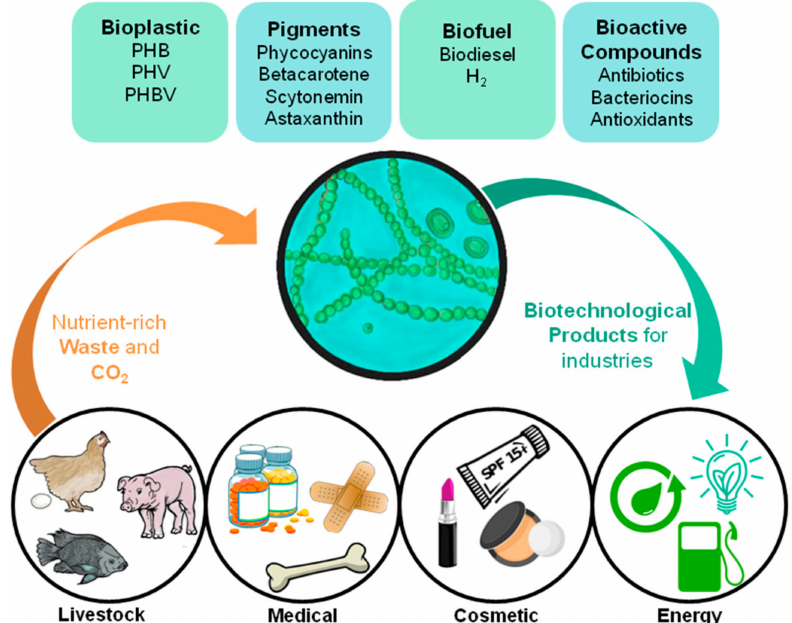
Figure 1. Diagrammatic representation showing cyanobacteria’s role in a circular economy-based system for various industries, and its possible products and waste